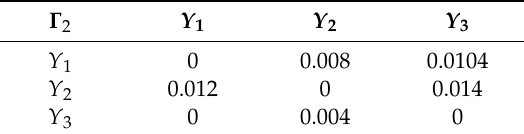
Table 8. The rejoice matrix Γ 2 .